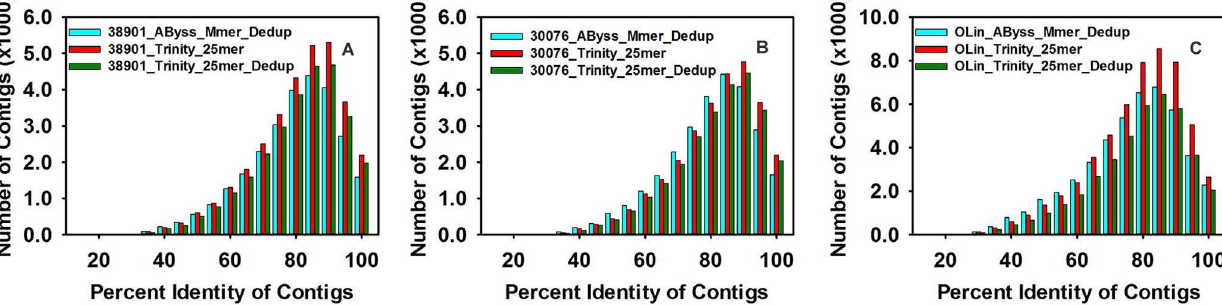
Fig. 4. Distribution of contigs with varying percent identity against the legume protein database. BLASTX searches were performed with the threshold value of 1 6 10 2 6 . A) 38901, B) 30076, C)